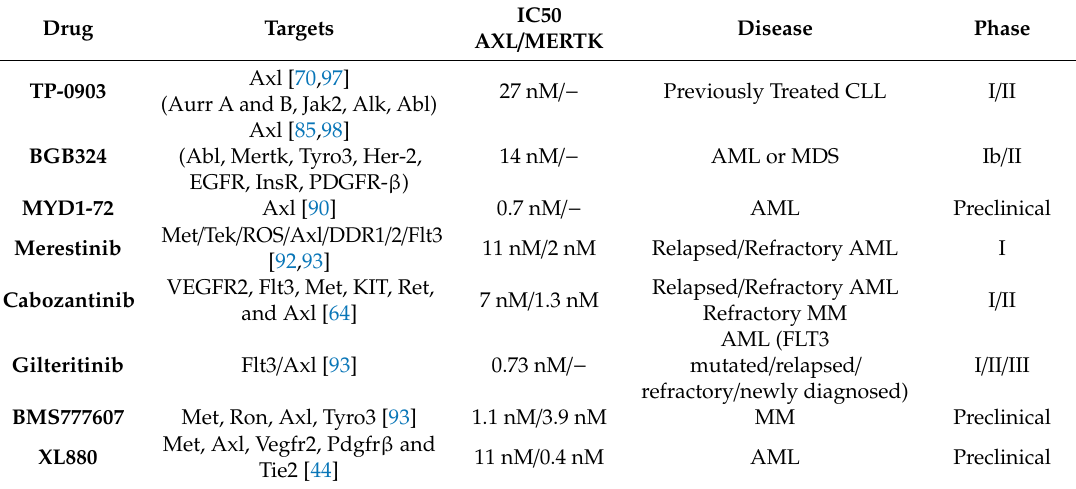
Table 1. AXL inhibitors in preclinical and clinical development of hematological cancers.